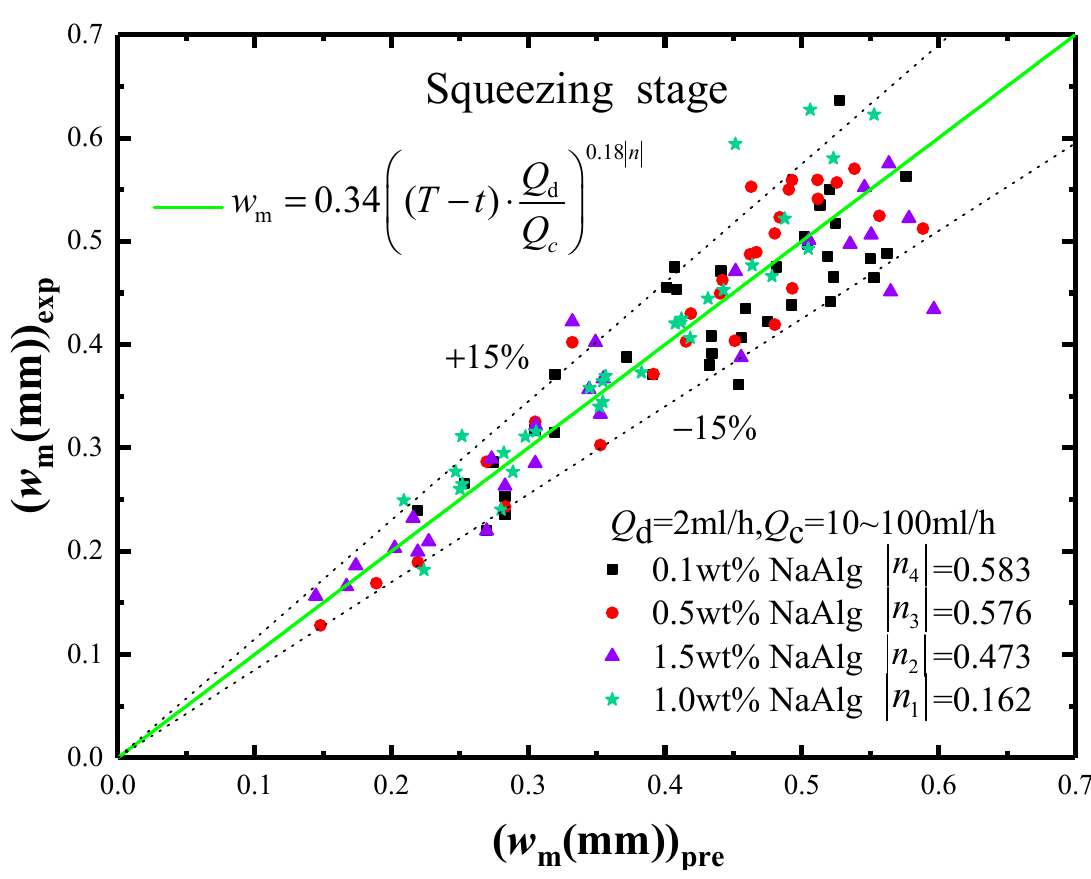
Figure 9. The accuracy analysis of w m prediction model in the squeezing stage.